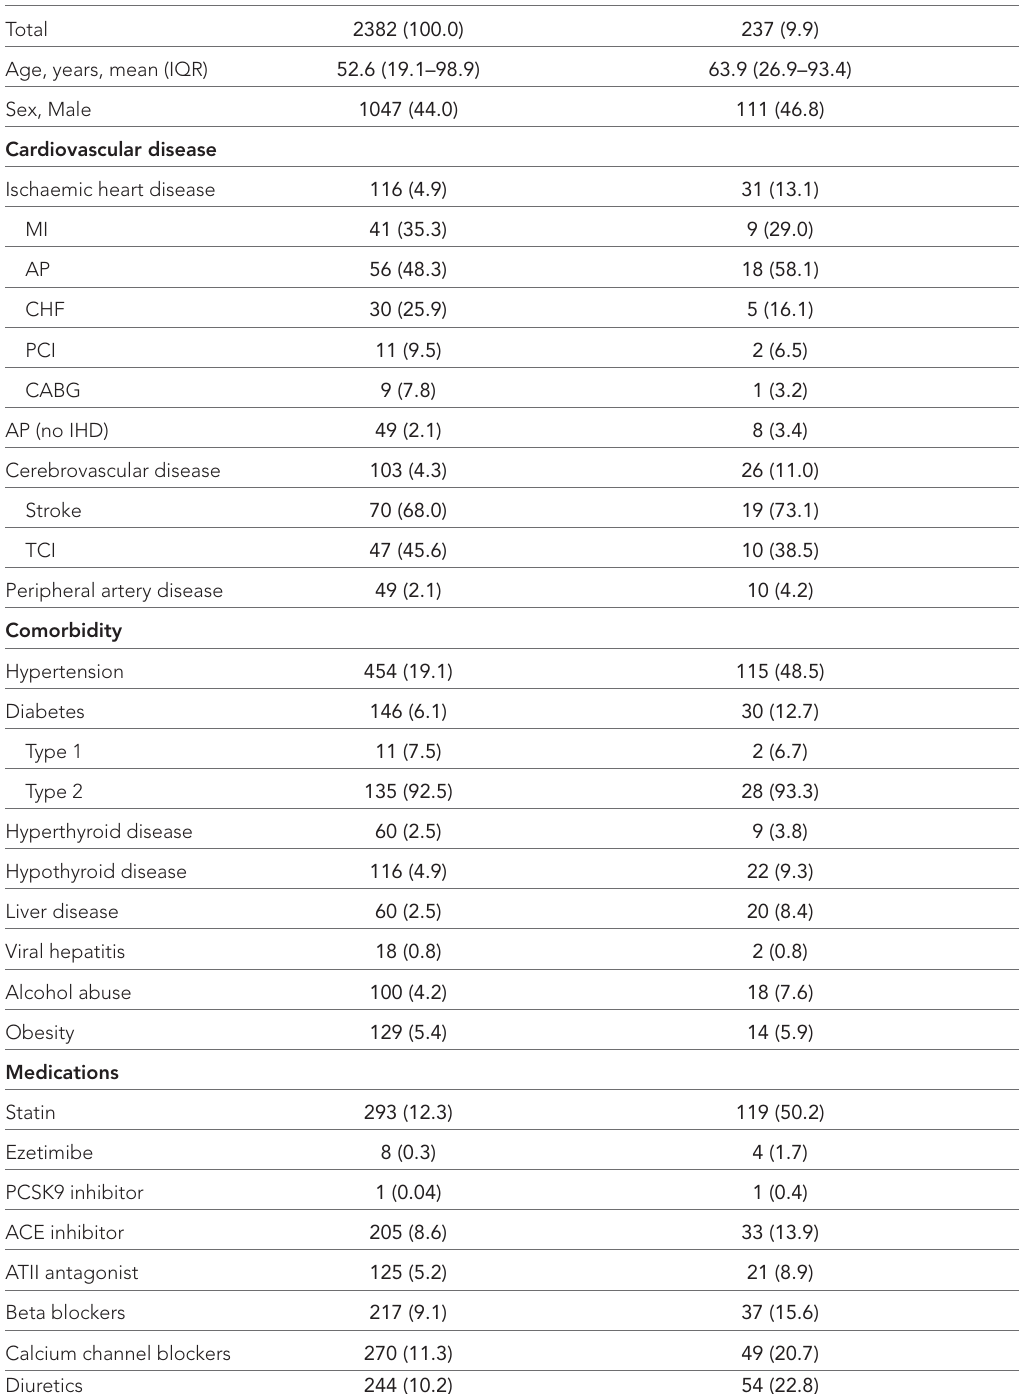
Table 1 Baseline